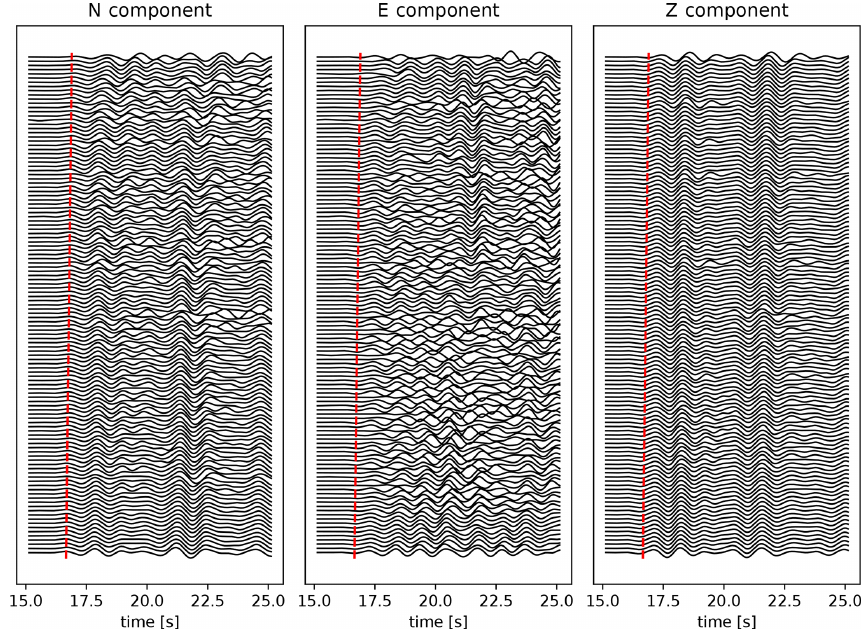
Figure 3. P waveforms recorded by the nodal array, ordered by distance from the earthquake epicentre, band-pass filtered in the 0.5–1Hz range, and scaled by the standard deviation of each trace. Time is relative to the start of the recordings and is synchronised with the waveforms shown in Fig. 1. For reference, the move-out is indicated by the red dashed